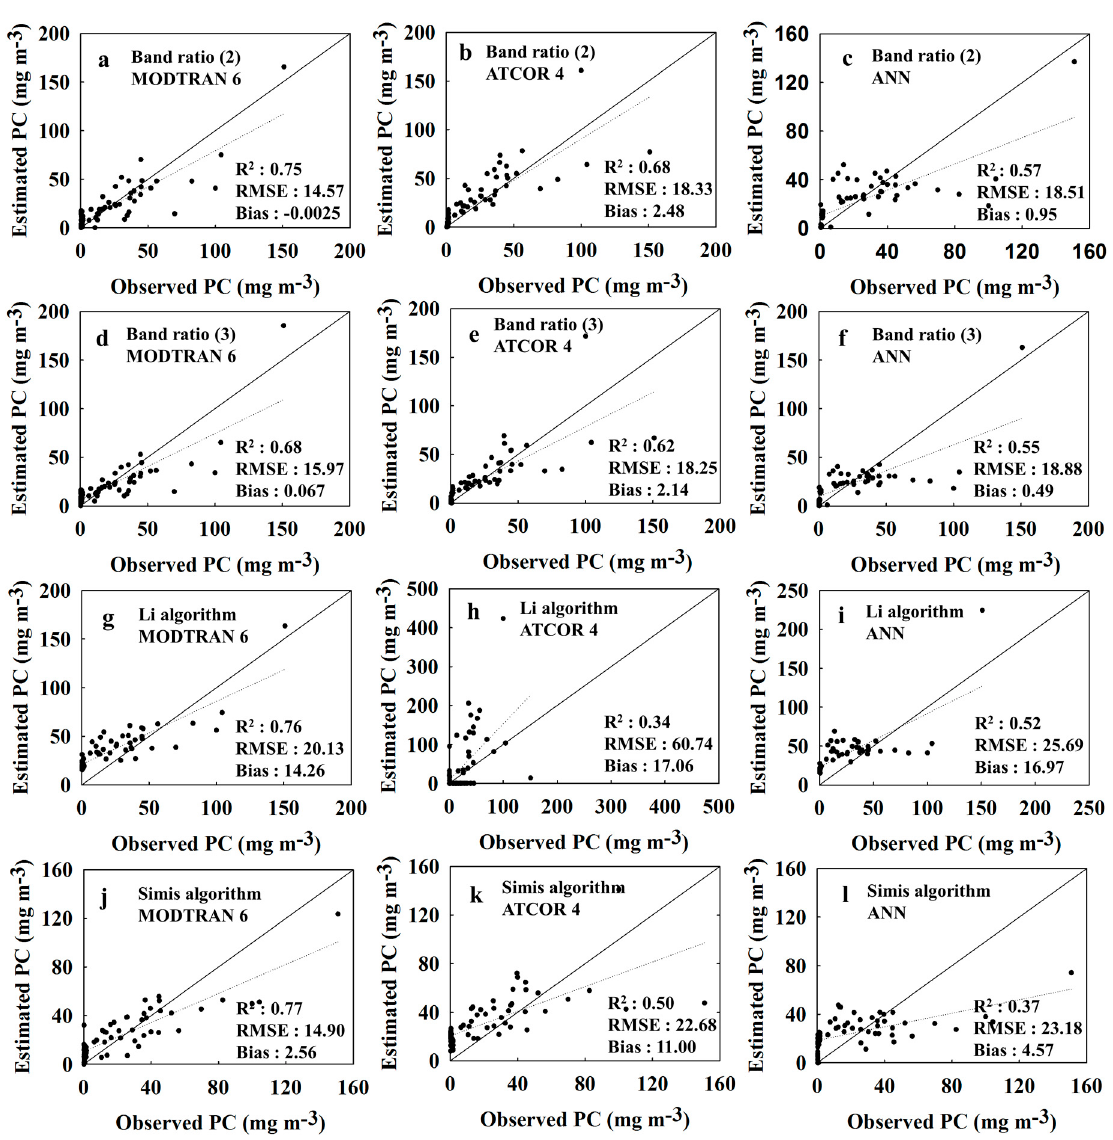
Figure 5. Optimized PC algorithm results with respect to in-situ and atmospherically corrected reflectance. Panels ( a – c ) show the band ratio (2) results. Panels ( d – f ) show the band ratio (3) results. Panels ( g – i ) show the Li algorithm results. Panels ( j – l ) show the Simis algorithm results.